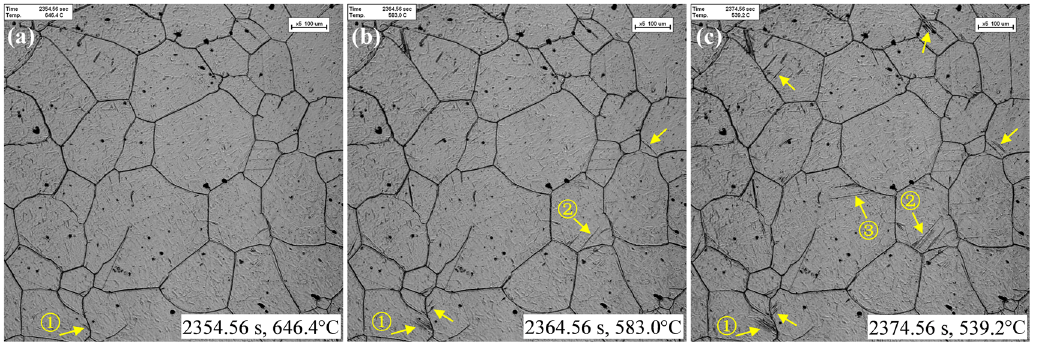
Figure 13: In situ observation of acicular ferrite precipitation during the cooling process at ( a ) 646.4°C, ( b ) 583.0°C and ( c )